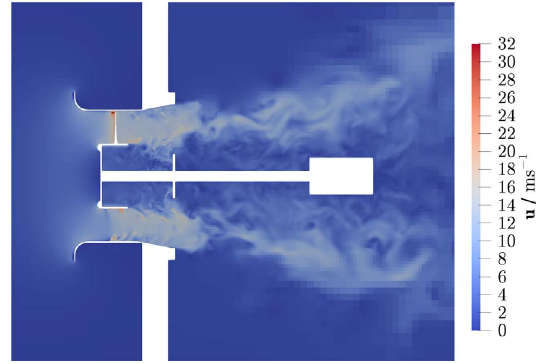
Figure 14. Unsteady velocity fi eld of the duct and wake area at a characteristic time instance.